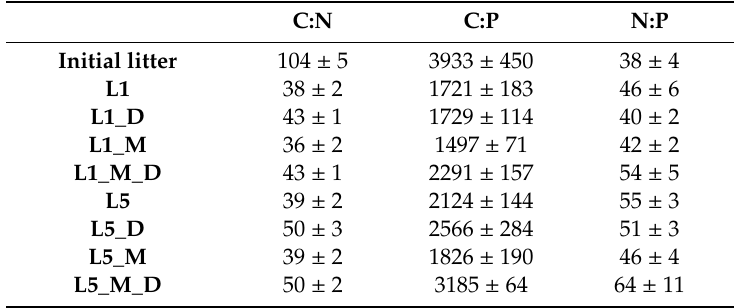
Table 4. Molar ratios of C, N and P of leaf biomass (mean ± standard error) at the beginning and at the end of the experimental period.